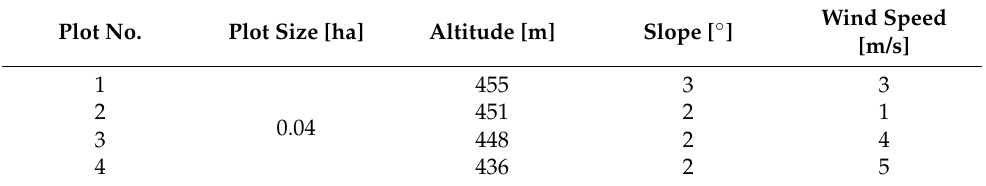
Table 1. Geographical characteristics per plot of study area. Plot